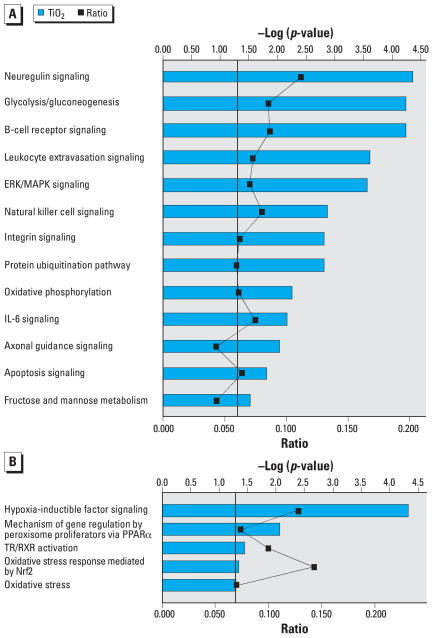
BV2 microglia were exposed to P25 (20 ppm) for 3 hr. IL-6, interleukin 6, PPARα, peroxisome proliferator-activated receptor α TR/RXR, thyroid hormone receptor/retinoid X receptor. (A) Core analysis of the down-regulated genes showed clustering around pathways associated with adaptive change and key energy production pathways. (B) Toxicity Pathway analysis indicated that P25 down-regulated genes in pathways associated with hypoxia, peroxisomes, and Nrf2-mediated oxidative stress.